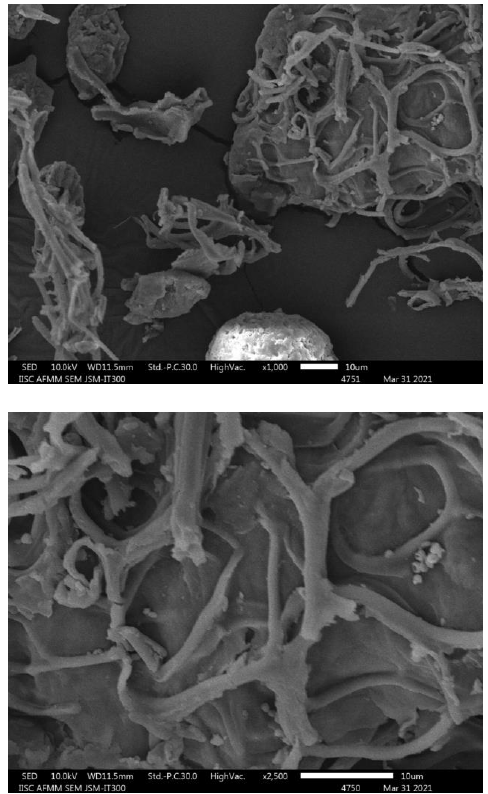
Figure 6. SEM images of TRP observed at 1000x (top) and 2500x (bottom) magnification